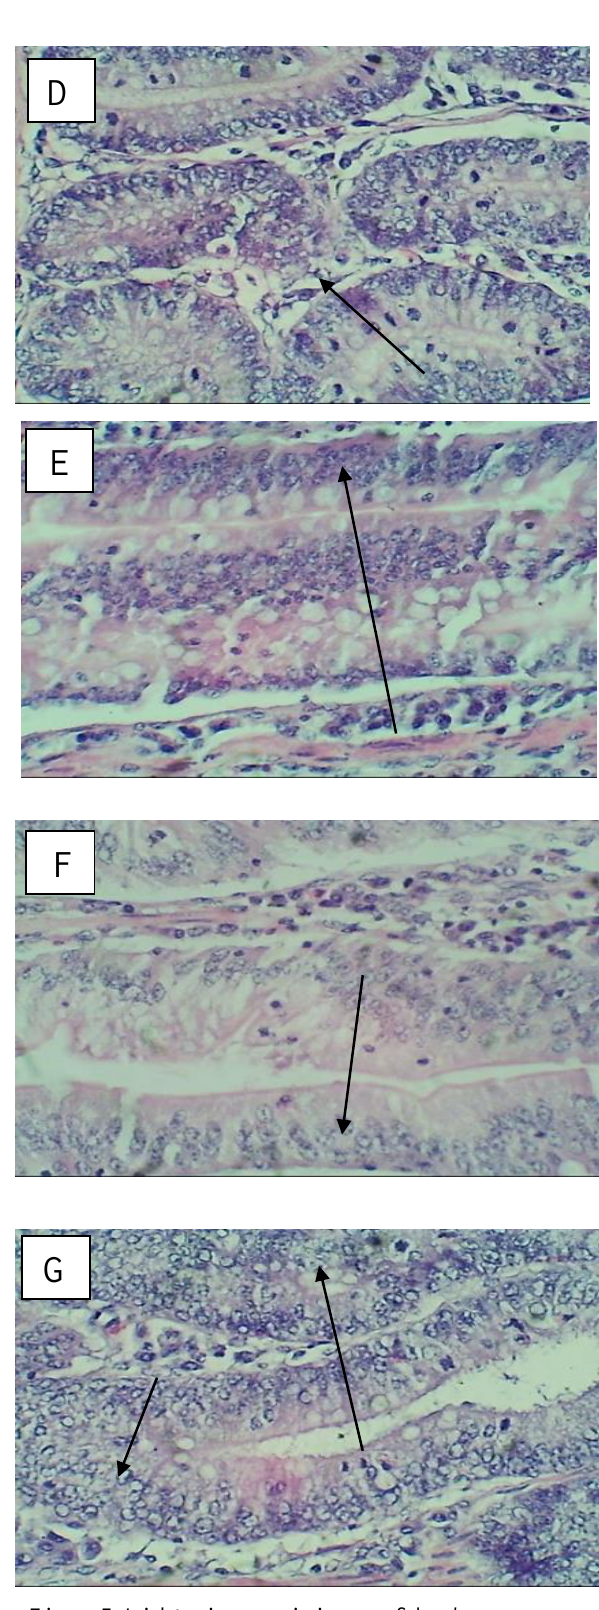
Figure 5. Light microscopic image of duodenum cross section histopathological and histomorphological changes in A(G1),B(G2),C(G3),D(G4),E(G5),F(G6), and G(7) the arrow indicates MNCs